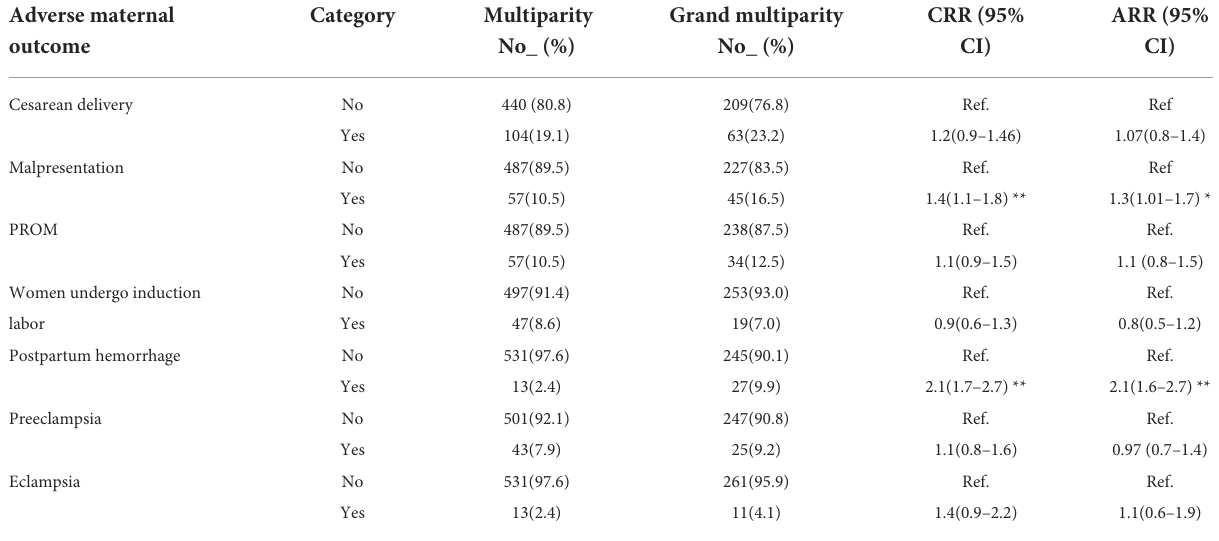
TABLE 3 In the Sidama Regional State of Ethiopia, 2021, the result of a modifier poison regression model to the probability of an adverse maternal outcome for grand multiparity. Adverse maternal Category outcome